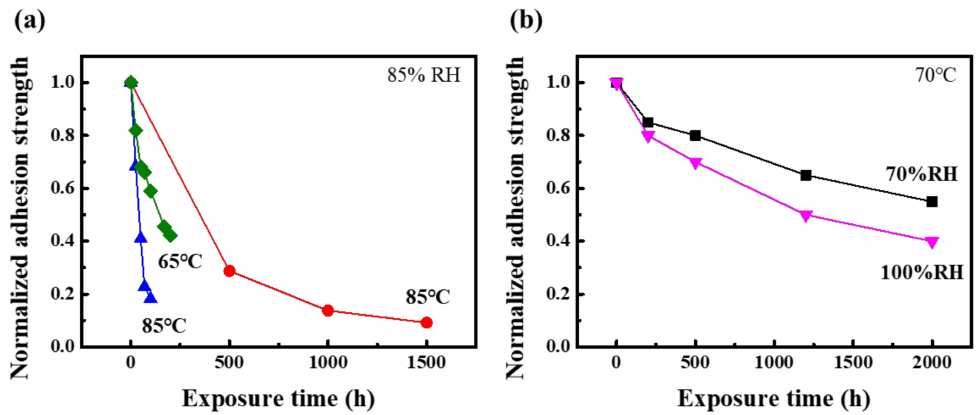
Figure 14. Variation in degraded adhesion strength with exposure time at ( a ) the same humidity (85% RH) with different temperatures and ( b ) the same temperature (70 ◦ C) with different